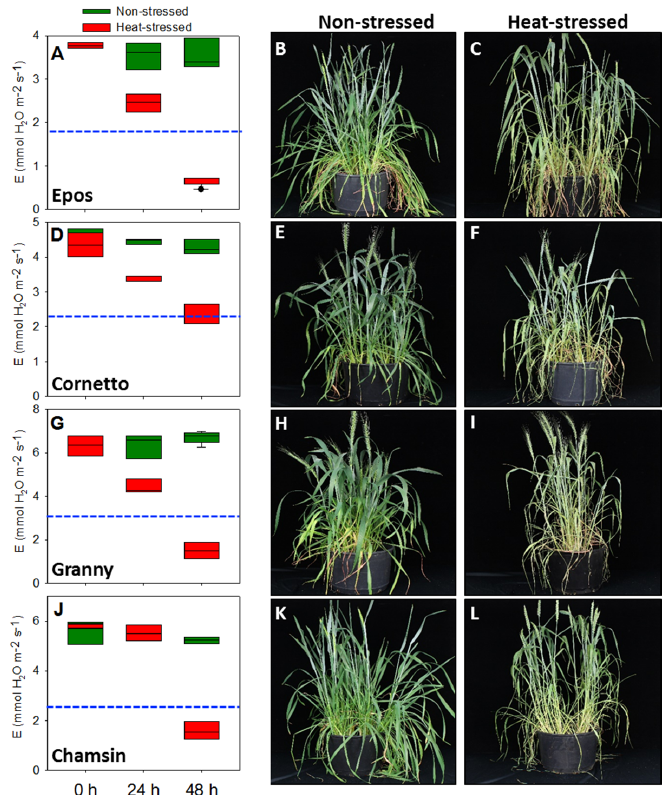
Figure 2. Moderate heat stress strongly alters transpiration rate of European summer wheat varieties. Physiological and phenotypical effects on varieties Epos ( A – C ), Cornetto ( D – F ), Granny ( G – I ), and Chamsin ( J – L ) are shown. Box plots show the central tendency and dispersion of the transpiration rate among all European cultivars. Green and red box plots represent non- and heat-stressed plants, respectively. Blue bars show 50% transpiration rate of non-stressed plants. 15–20 plants of each line were examined.